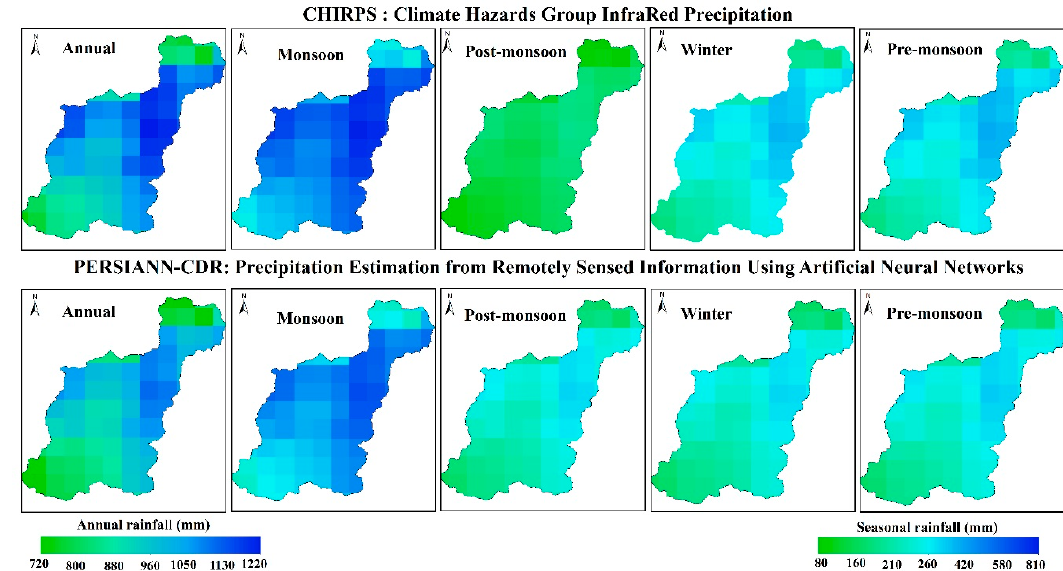
Figure 2. Spatial distribution of mean annual and seasonal rainfall (mm). Top panel distribution is from reanalysis and bottom panel from satellite-based gridded datasets derived using GEE.